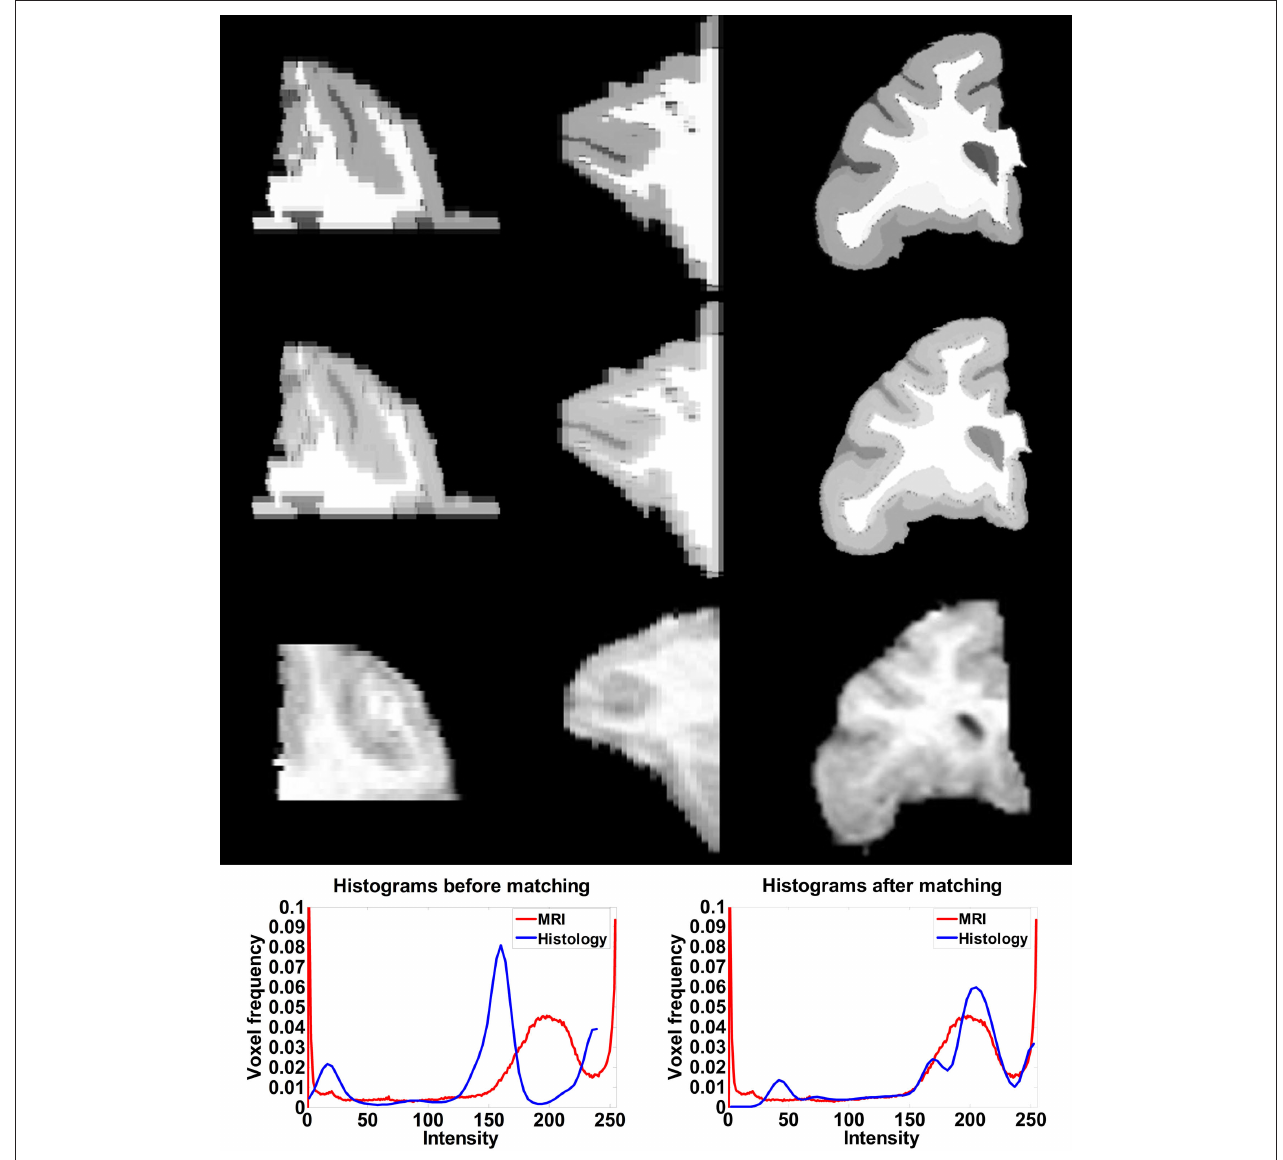
FIguRe 4 | Axial (left), sagittal (middle), and coronal (right) slices of histology image before (first row) and after histogram matching (second row), the corresponding MRI slices (third row). Histograms of the histology image before (fourth row left) and after (fourth row right) histogram matching together with the histogram of MRI ( Table 3 ). For some of the subjects, GM/CSF mean distances were comparable with the results obtained when the segmented histological images were used in registration ( Table 2 , subject numbers in red). However, because of the torn and miss-